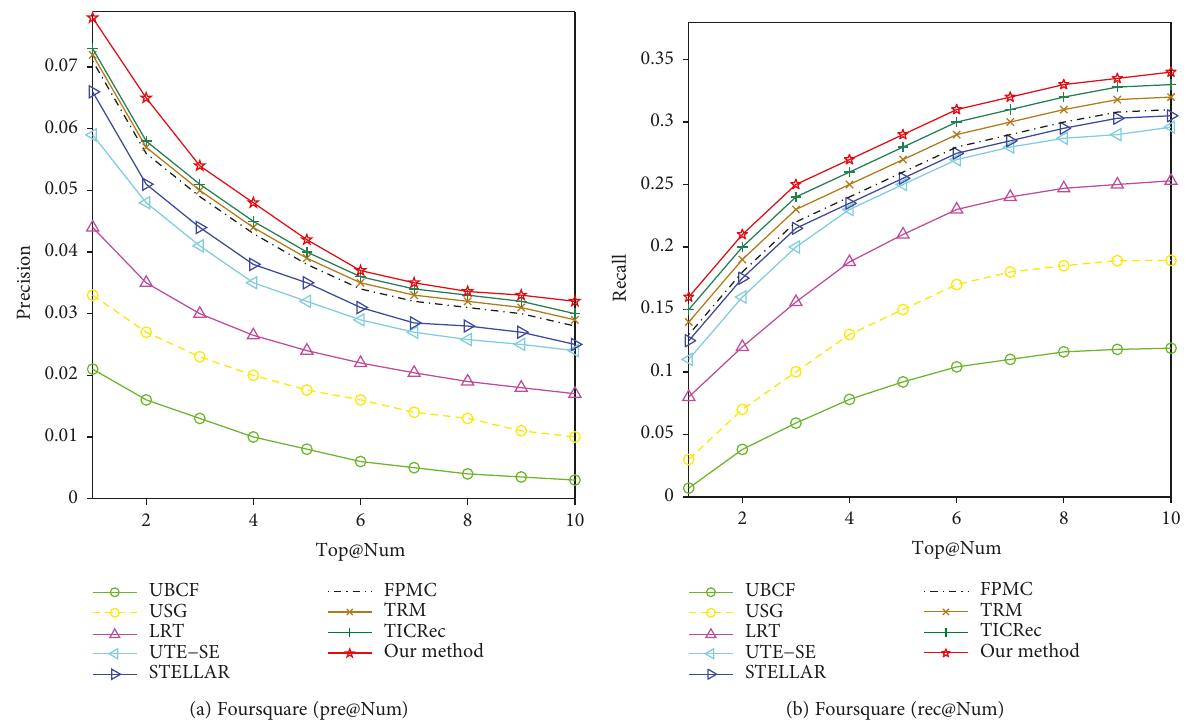
Figure 5: Performance comparison on the Foursquare